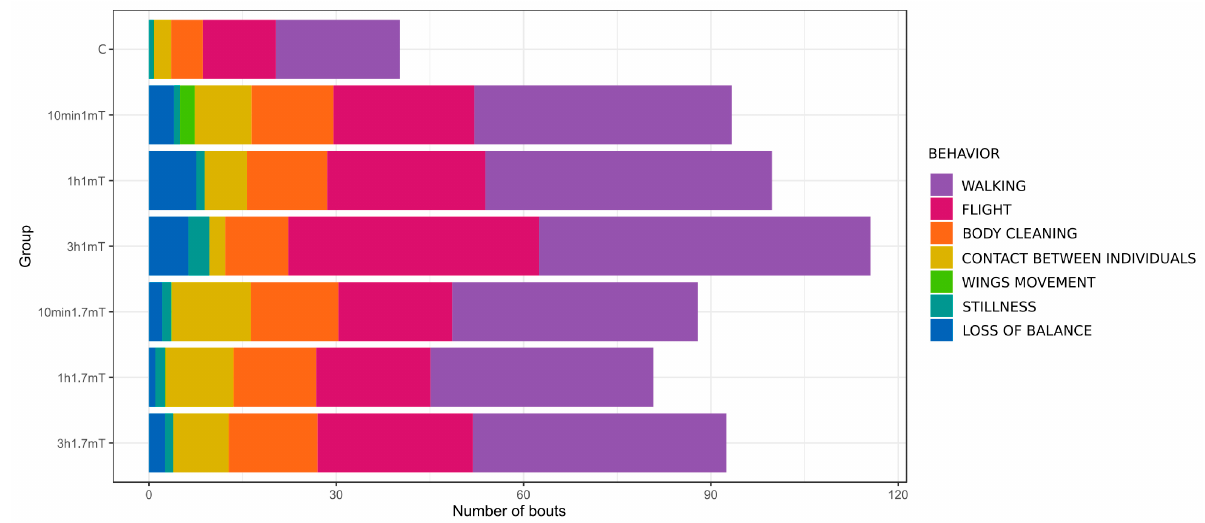
Figure 2. Mean number of bouts per bee. All exposed groups present visible differences from the control, with a much higher total number of bouts. Details under Figure 1.